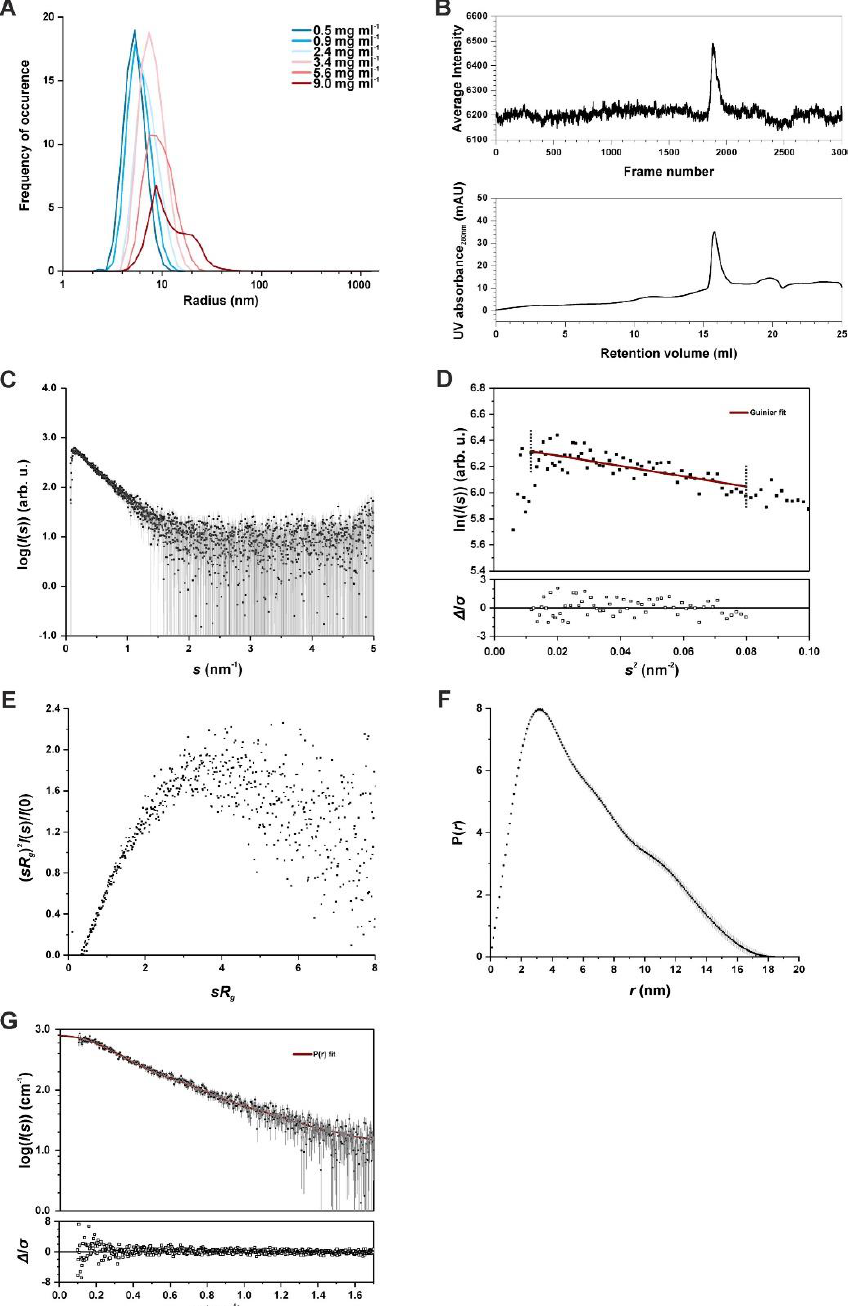
Figure 2. Structural analysis of SAUL1 monomers. ( A ) DLS measurements of different SAUL1 concentrations ranging from 0.5 to 9.0 mg mL −1 in 50 mM Tris-HCl pH 9 and 250 mM NaCl. Detected radii shift to higher values and multiple radii with a protein concentration higher than 2.4 mg mL −1 . ( B ) Scattering intensities of monodisperse SAUL1 in the SEC-SAXS experiment with a loading concentration of 4.38 mg mL −1 and chromatogram of the UV absorption at 280 nm. ( C ) Scattering data of SAUL1. Log-linear plot of I( s ) versus s . ( D ) The upper plot shows the Guinier fit (red) of the SAXS data. Dotted lines mark the fit range ( s min = 0.005 nm −1 and sR g max = 1.3). The lower plot shows the standardized residual plot. ( E ) Dimensionless Kratky plot with the intensities normalized to the forward scattering intensity ( I (0)) and the radius of gyration ( R g ). ( F ) P( r ) versus r profile of SAUL1. ( G ) Fit of the P( r ) function (red) to the experimental SAXS data. The lower plot depicts a standardized residual plot.